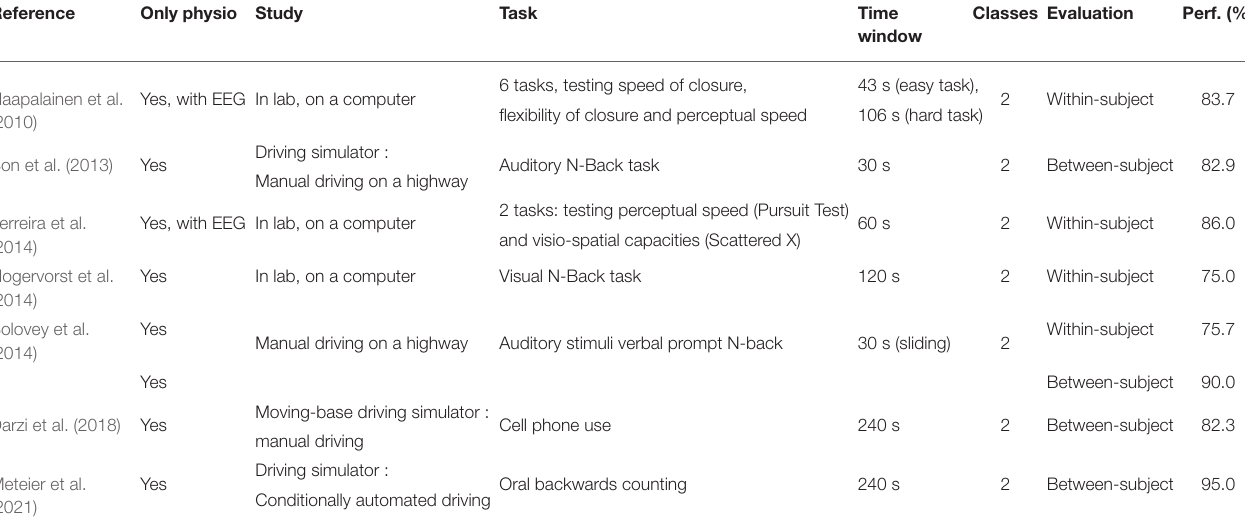
TABLE 1 | State of the art of previous similar